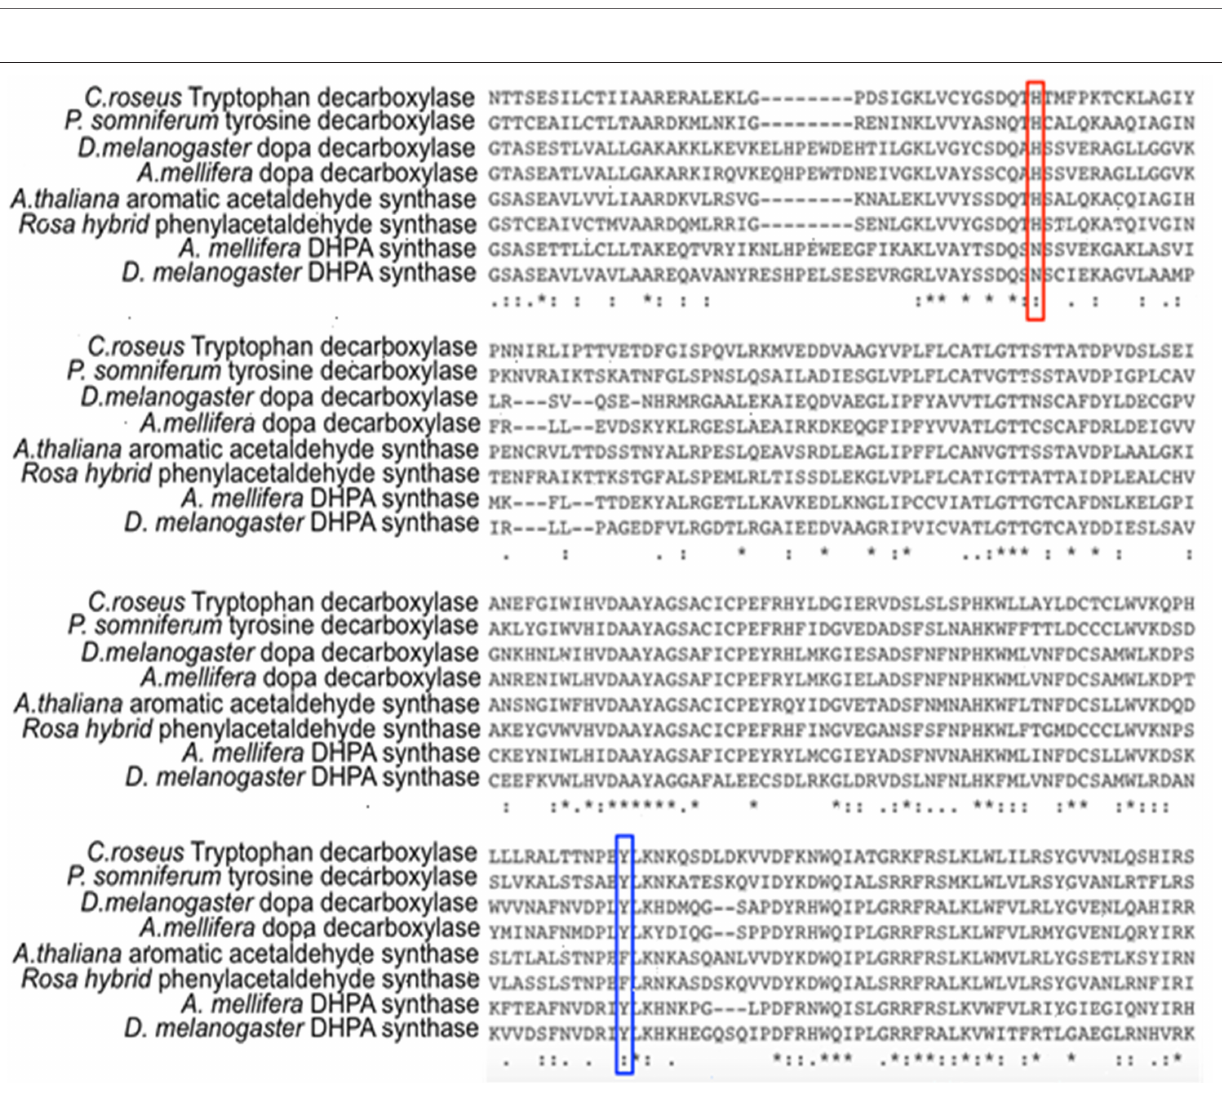
FIGURE 7 | Partial protein sequence alignment of plant and insect decarboxylases and aromatic acetaldehyde synthases. Catharanthus roseus tryptophan decarboxylase (P17770), Papaver somniferum tyrosine decarboxylase (AAC61842), Drosophila melanogaster dopa decarboxylase (NP_724164.1), Apis mellifera dopa decarboxylase (XP_394115.2), Arabidopsis thaliana aromatic acetaldehyde synthase (NP 849999), Rosa hybrid cultivar phenylacetaldehyde synthase (ABB04522.1), Apis mellifera 3,4-dihydroxyphenylacetaldehyde (DHPA) synthase, Drosophila melanogaster DHPA synthase (NP_724162.1) protein sequences are compared. The conservations of His vs. Asn residues at the equivalent position with His192 of Drosophila melanogaster dopa decarboxylase (NP_724164.1) are highlighted by red box. The conservations of flexible loop Tyr vs. Phe at the equivalent position with Tyr348 of Catharanthus roseus tryptophan decarboxylase (P17770) are highlighted by blue